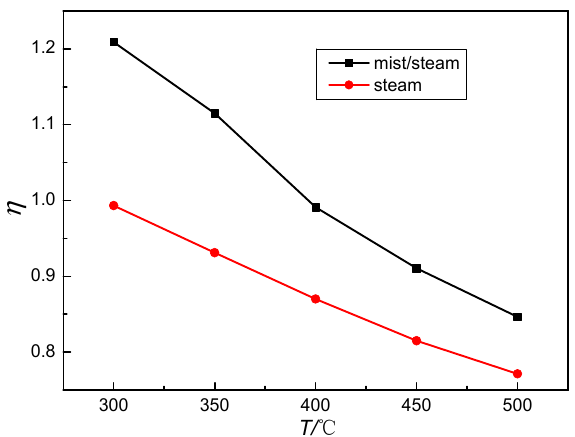
Figure 9. Variation in the heat transfer performance factor of the mist/steam and steam cooling ribbed channels with the coolant temperature.